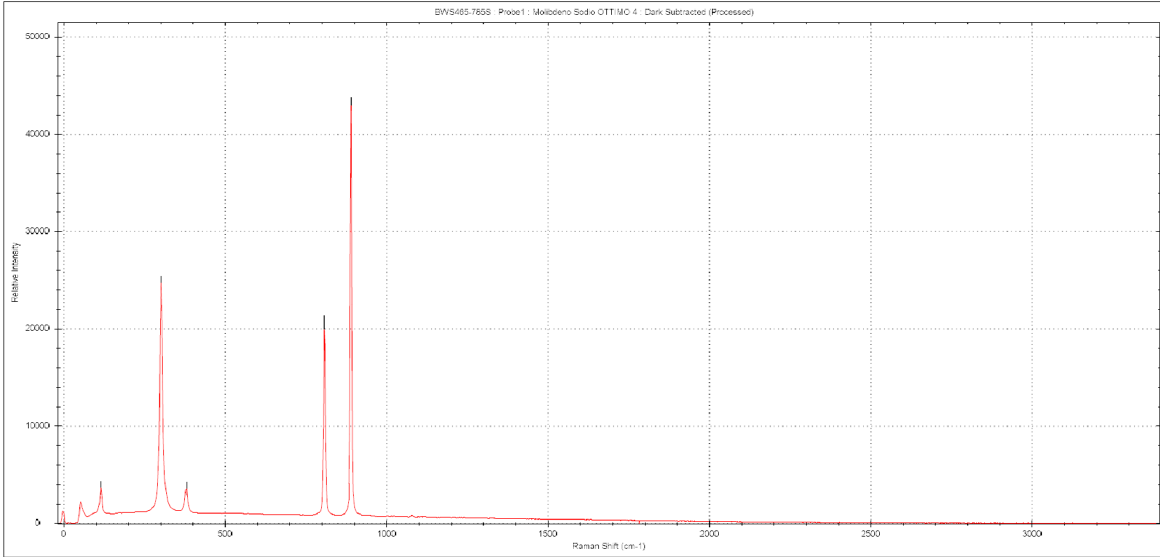
Molecules 2023 , 28 , x FOR PEER REVIEW Figure 10. Raman spectrum of sodium molybdate. Figure 10. Raman spectrum of sodium molybdate. Figure 10. Raman spectrum of sodium molybdate.